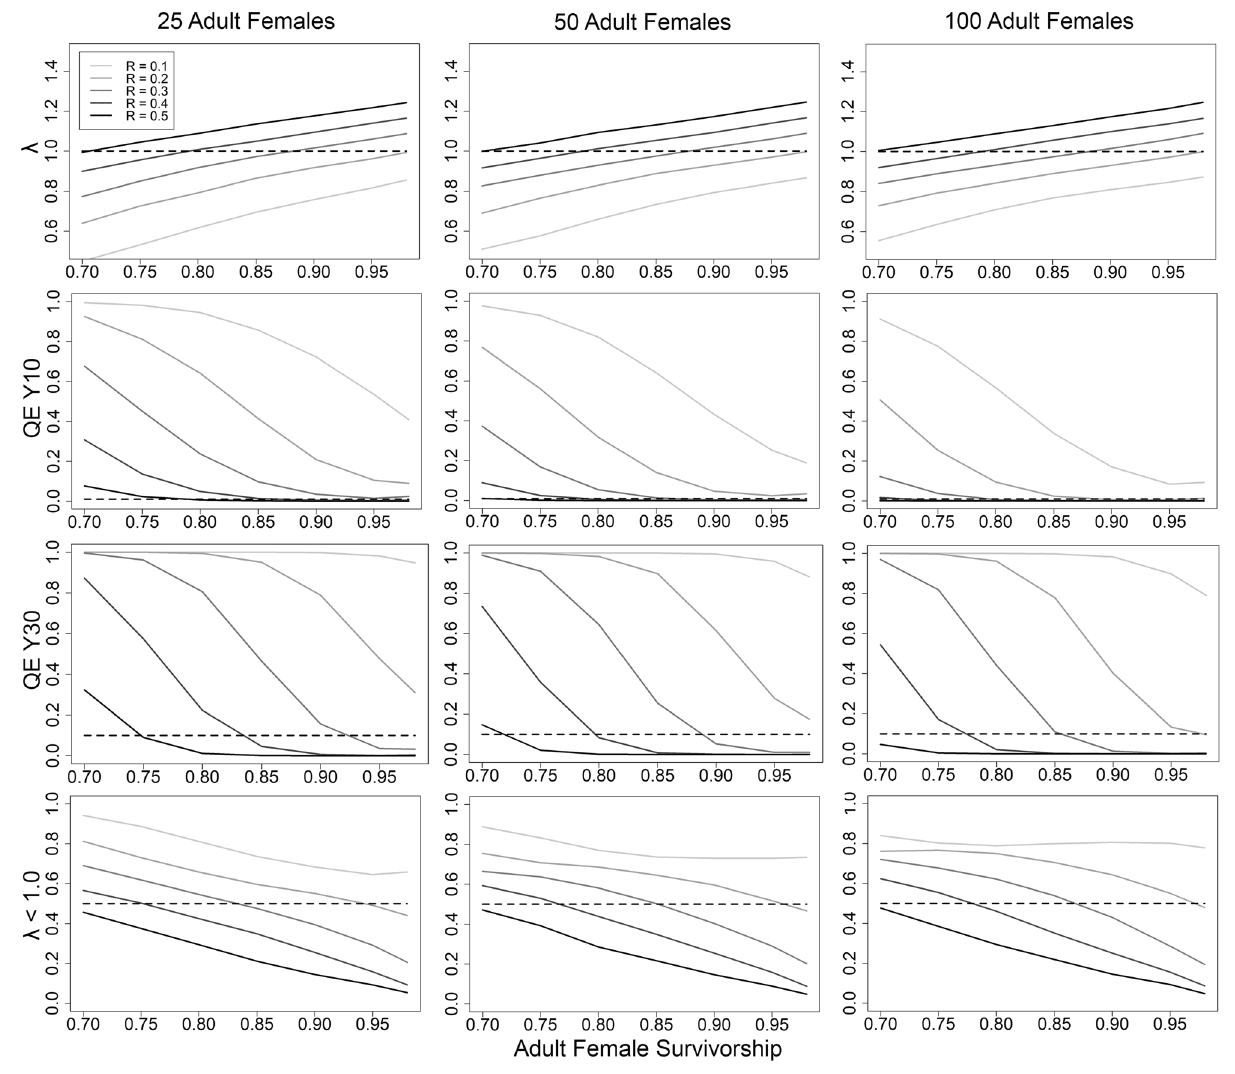
Figure 1. Relationships between recruitment (R), survival of adult females, starting adult female abundance, and population growth (λ; top row), the probability of quasi-extinction ( QE ; adult female abundance ≤ 5) at years 10 and 30 (middle rows) and the proportion of simulations resulting in mean λ < 1.0, based on 10,000 stochastic simulations of population trajectories. Dashed lines for QE (10) and QE (30) indicate the persistence threshold: 0.01 and 0.10